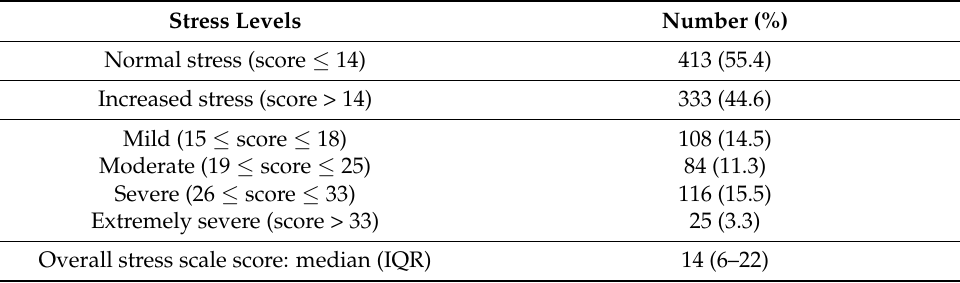
Table 2. Stress levels of the healthcare workers in Da Nang ( n = 746). Stress Levels Number (%) Normal stress (score ≤ 14) 413 (55.4) Increased stress (score > 14) 333 (44.6) Mild (15 ≤ score ≤ 18) 108 (14.5) Moderate (19 ≤ score ≤ 25) 84 (11.3) Severe (26 ≤ score ≤ 33) 116 (15.5) Extremely severe (score > 33) 25 (3.3) Overall stress scale score: median (IQR) 14 (6–22) IQR: interquartile range.